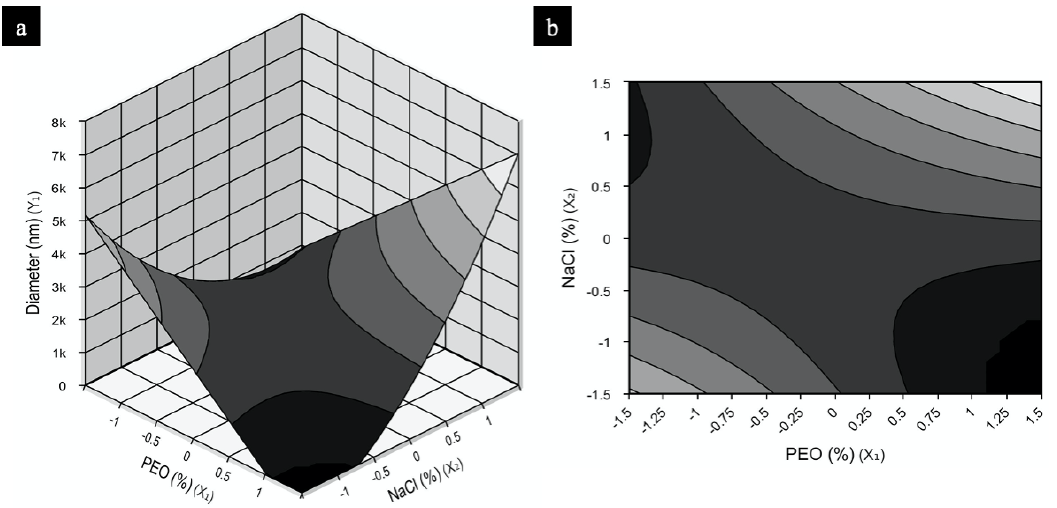
Figure 2. PEO response and contour surfaces for fiber diameter containing as a function of concentrations PEO (%) and NaCl (%): ( a ) response surface, ( b ) contour surface.